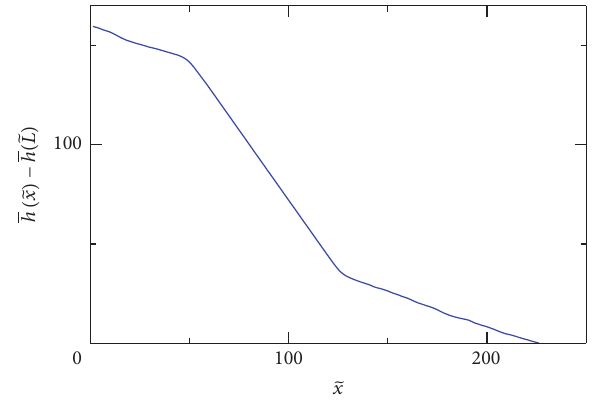
Figure 7: Averaged height profiles ℎ(̃𝑥) of a vicinal surface. 𝑘 𝐵 𝑇/𝜖 = 0.63 . Size: 160√2 × 160√2 . 𝑁 MCS/site. ̃𝑥 = √𝑥 2 + 𝑦 2 ;